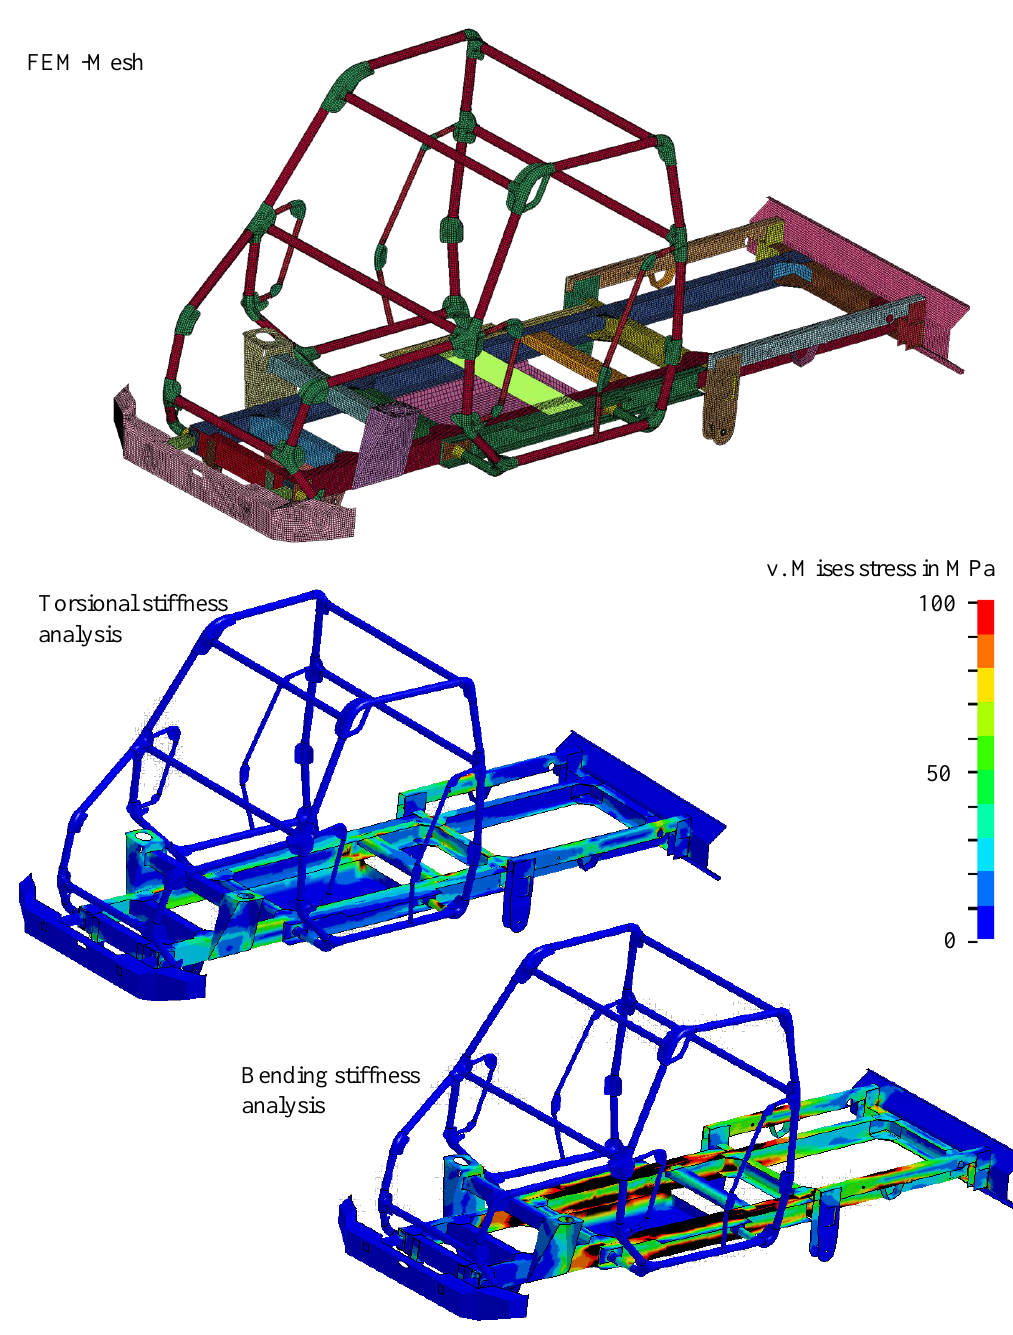
Figure 4. Finite element modeling (top), determination of torsional stiffness (lower left) with an applied load of ± 5000N in vertical direction, and determination of bending stiffness (lower right) with an applied load of ± 50,000N as examples for the conducted numerical